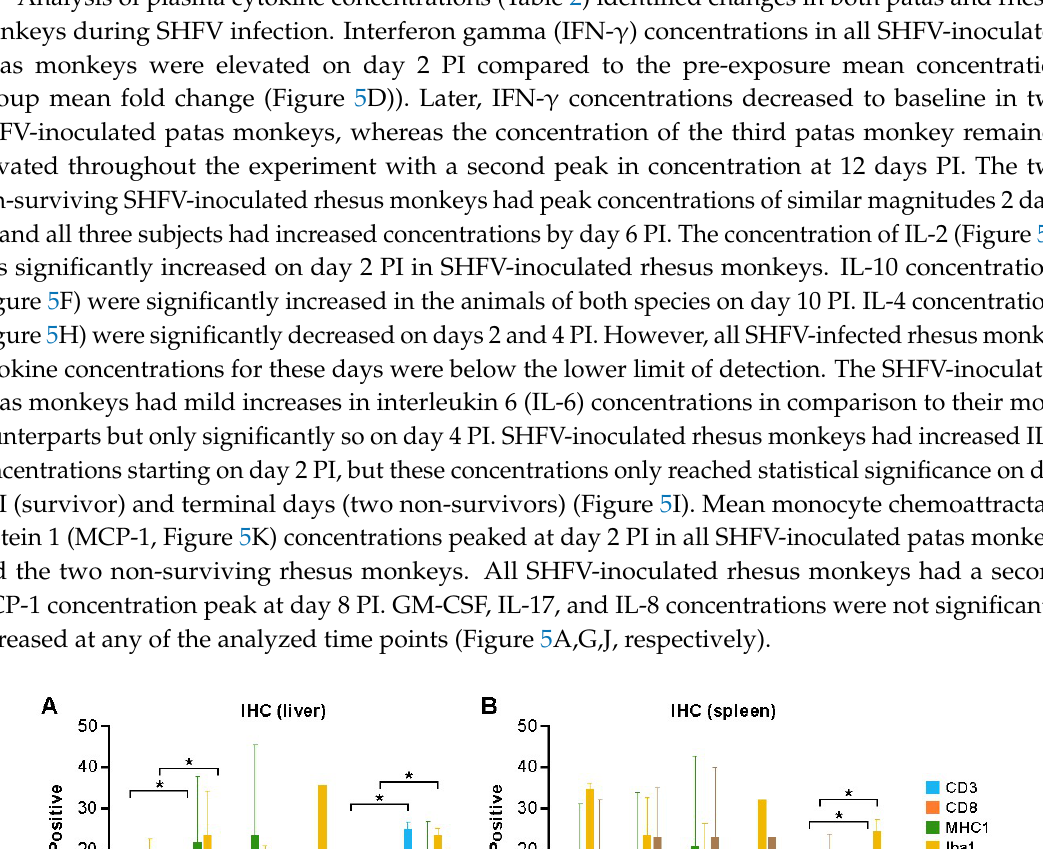
Figure 5. Immunophenotype of the liver and spleen ( A , B ) and plasma cytokine concentrations of SHFV-infected and mock-infected animals. The mean quantitative immunohistochemistry values of the indicated marker in mock- and SHFV-inoculated patas and rhesus monkey livers and spleens ( A , B ). The mean plasma concentrations in pg per mL of indicated analyte for mock (open symbols) and SHFV-inoculated (closed symbols) patas monkeys (orange) and rhesus monkeys (blue) ( C – K ). The gray lines represent the lower and upper limits of quantitation (LLOQ and ULOQ, respectively). The error bars represent standard deviation. * symbols represent p < 0.05 and are colored according to species. Flow cytometry of whole blood revealed that CD4 + T-cells were decreased in SHFV-inoculated patas monkeys on days 2–8 and day 15 PI. CD4 + T-cell numbers did not significantly changed in SHFV-inoculated rhesus monkeys (Figure 6A). CD8 + T-cell numbers were decreased in both SHFV- inoculated patas and rhesus monkeys (days 2–8 and days 2, 6 PI, respectively) (Figure 6B). Increased